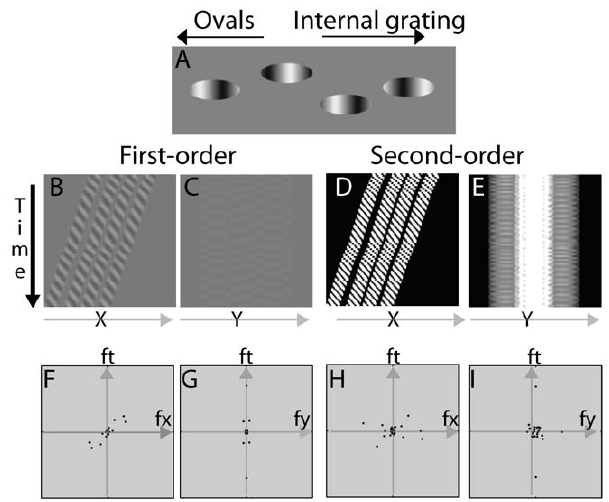
Figure 4. Motion energy analysis for the peripheral decelera- tion illusion (See Movie S3). A) A single frame in the peripheral deceleration illusion. Ovals drift from left to right across the screen. Inside each oval is an internal gradient that moves in the direction opposite to the motion of the oval. When viewed foveally, observers can separate the ovals and internal grating; when viewed peripherally, the speed of the ovals is determined by the internal motion, yet it is difficult to see the motion of the internal gradient. In the supplemen- tary movie, the observer can adjust the speed of the internal grating. When the gradient is faster than the ovals, a shift from foveal to peripheral viewing will make the ovals appear to accelerate; when the gradient is slower than the ovals, a shift from foveal to peripheral viewing will make the ovals appear to decelerate and even reverse direction (creating the paradoxical view that the ovals are moving slowly leftward, yet somehow get to the far right side of the screen). B&C) First-order motion plots in the x-t and y-t planes. D&E) Projections of DC-removed and rectified second-order peripheral deceleration movie in the x-t and y-t planes. F–I) Fourier analysis of the